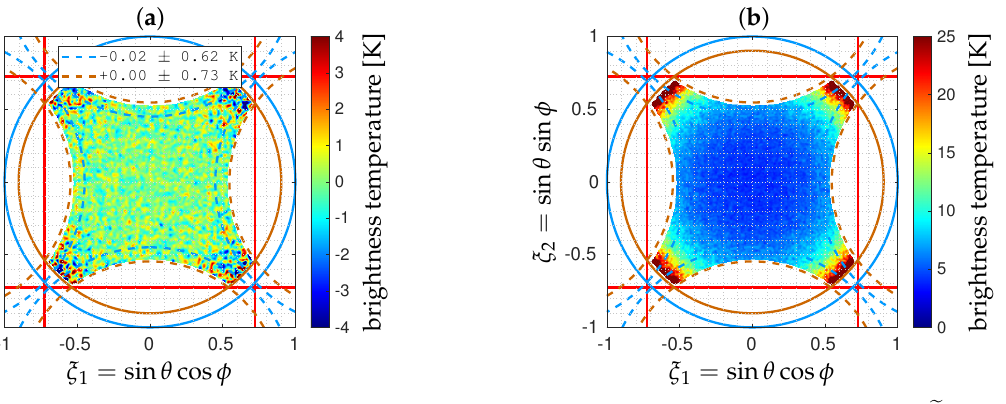
Figure 16. Average map ( a ) and standard deviation map ( b ) of 1000 error maps (cid:101) T n − T obtained in X polarization with the cross-shaped array shown in Figure 4 with the shortest spacing d set to 0.69 λ (similar results are obtained in Y polarization). In every case, complex visibilities V have been blurred by an additive Gaussian noise ∆ V with standard deviation set to 0.1 K and the singular vectors V (cid:96) of (cid:101) G corresponding to the 16 smallest singular values σ (cid:96) have been discarded prior to the inversion. These maps have to be compared to those in Figures 10a and 11a where these singular vectors were taken into account in the computation of (cid:101) G +